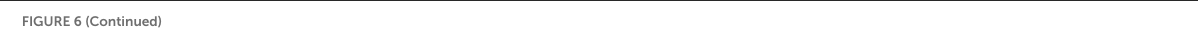
FIGURE6(Continued) trans -2-hexenal. (J) Dose-response curves of ORNs in LP5II to α -terpinene with the EC 50 value of 8.36 × 10 − 6 g ( n = 4). (K) SSR traces showing ORNs in LP5II were activated by α -terpinene. Paraffin oil (PO) was used as a control. Chemicals were tested at a dose of 10 − 7 , 10 − 6 , 10 − 5 , 10 − 4 , and 10 − 3 g, respectively. Error bars indicate SEM. Red bars indicate the 300ms stimulation of